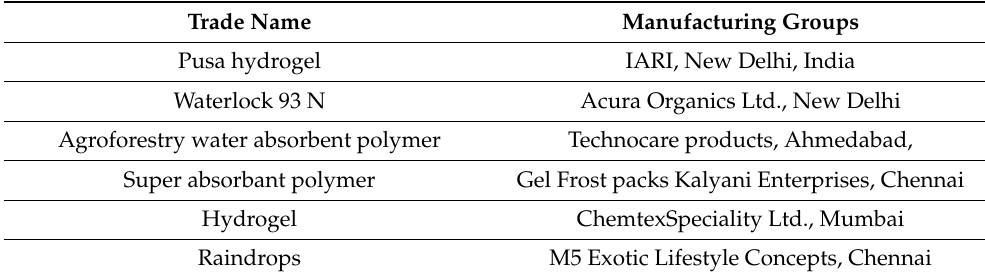
Table 3. Agricultural hydrogel products in India. Trade